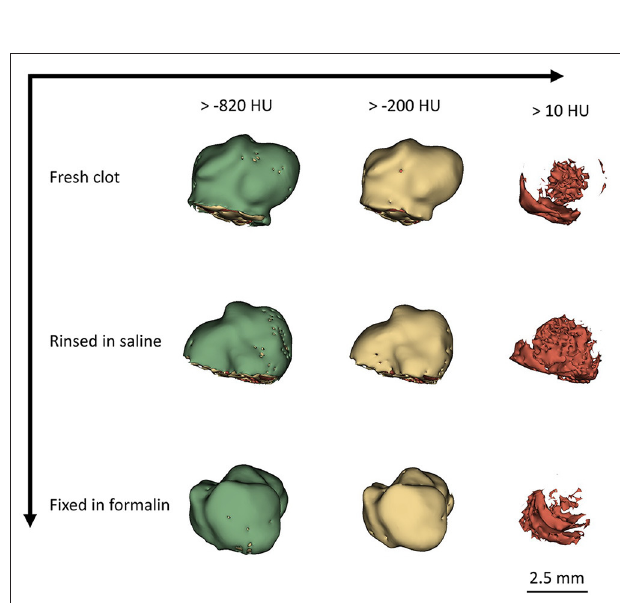
FIGURE 2 | Segmentation of clot at different processing